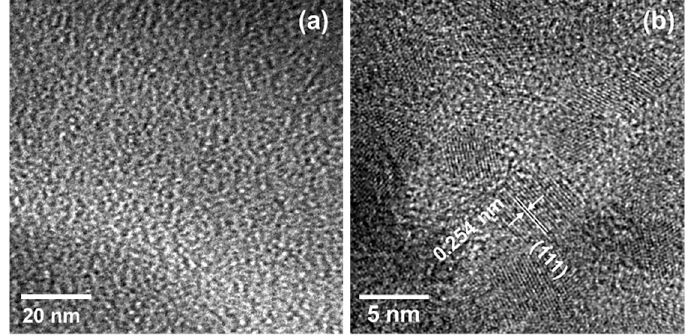
Figure 8. TEM images of the VH-SQ-derived S1 after heat treatment at ( a ) 1400 and ( b ) 1600 °C.